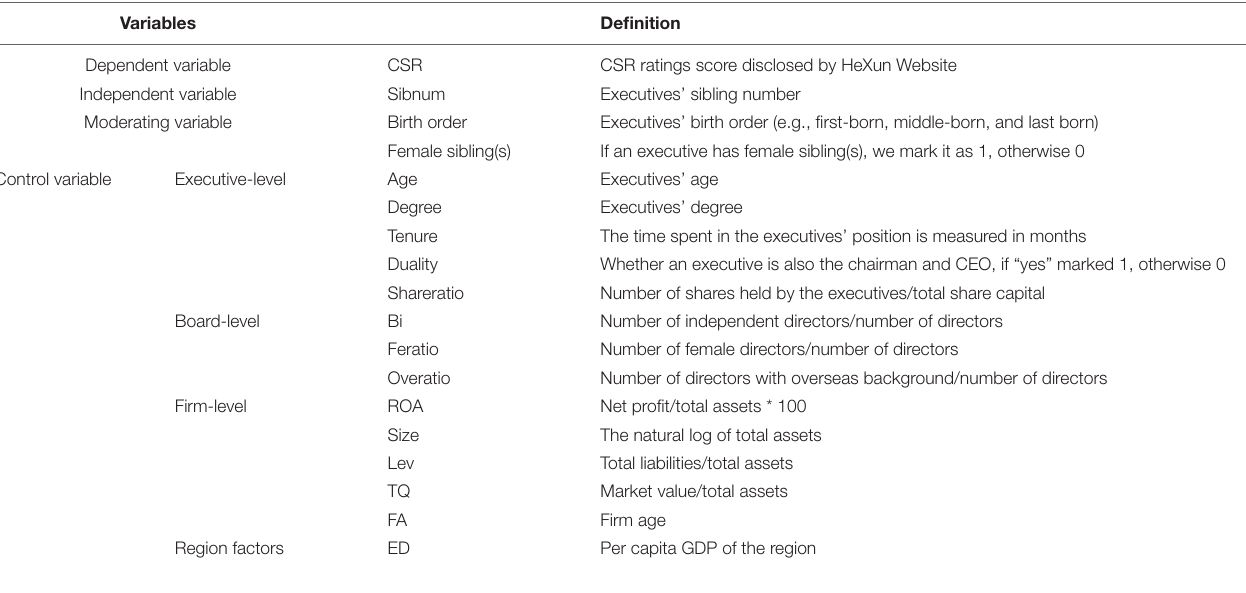
TABLE 1 | Variable